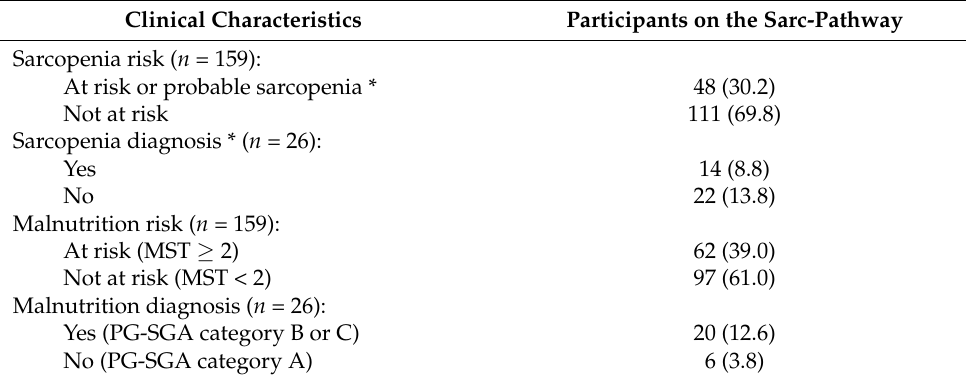
Table 5. Summary of participants’ sarcopenia and malnutrition risk and diagnostic status. Clinical Characteristics Participants on the